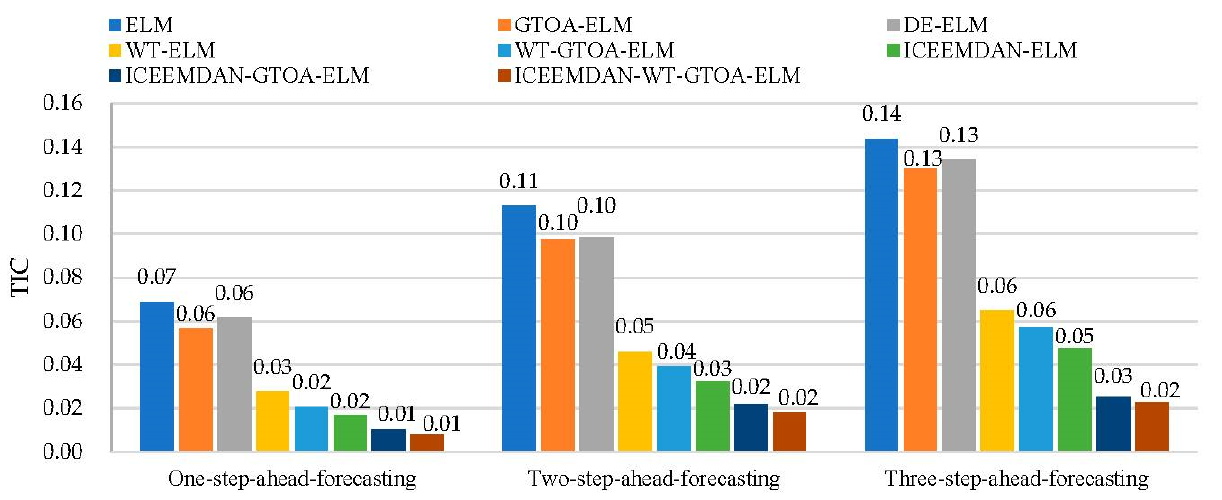
Figure 12. TIC of PM2.5 forecasting.